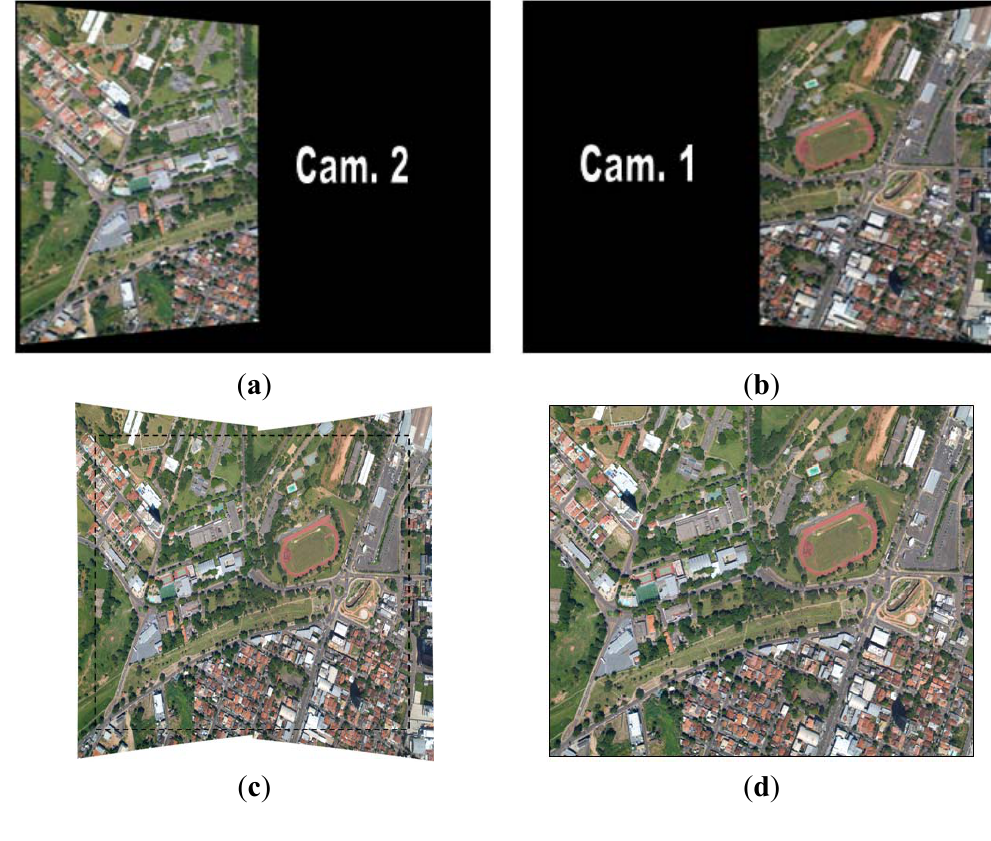
Figure 1. Resulting rectified images of dual cameras: ( a ) left image from camera 2, and ( b ) right image from camera 1, ( c ) resulting fused image from two rectified images after registration and, ( d ) cropped without the